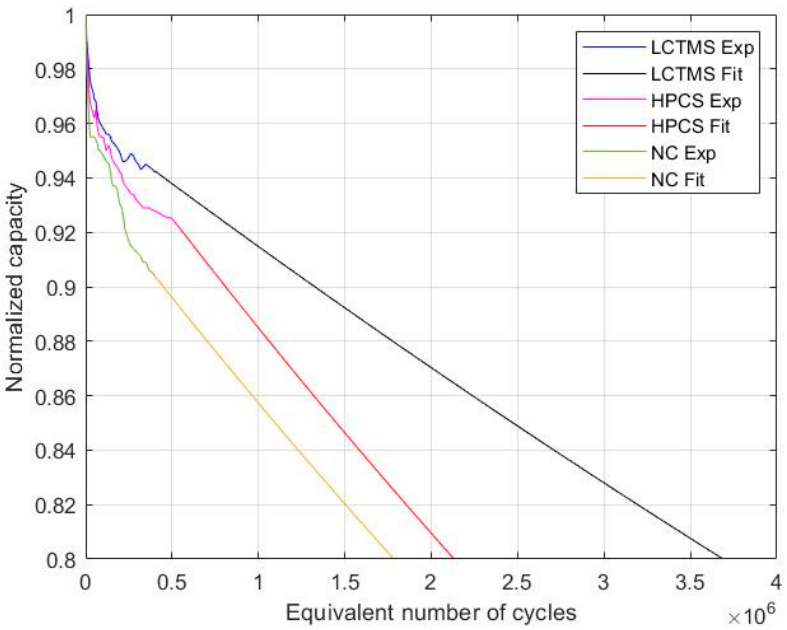
Figure 7. Linear extrapolation for capacity fade in three case studies: without any TMS under NC, with HPCS, and with LCTMS.